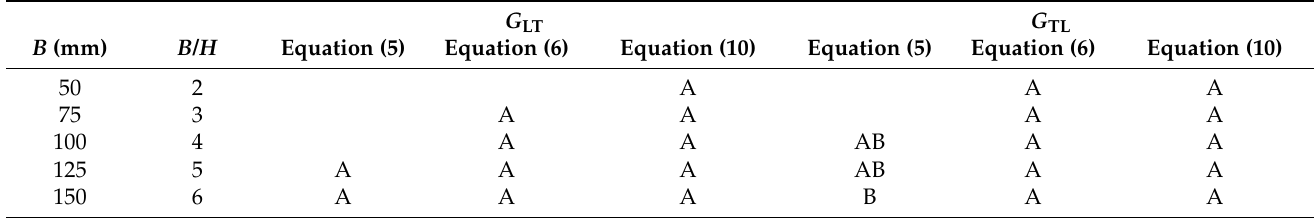
A A A AB A A A A A B A A Significance level is greater than 0.05 among the samples with the same letters in a same column. Table 3 lists the unpaired t -test results performed on the difference in the G LT and